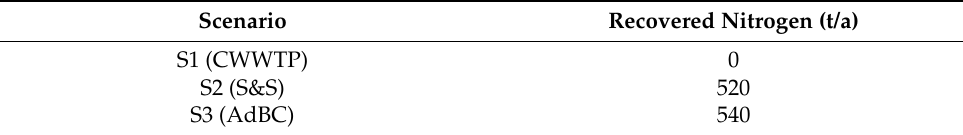
Table 1. Nitrogen recovery